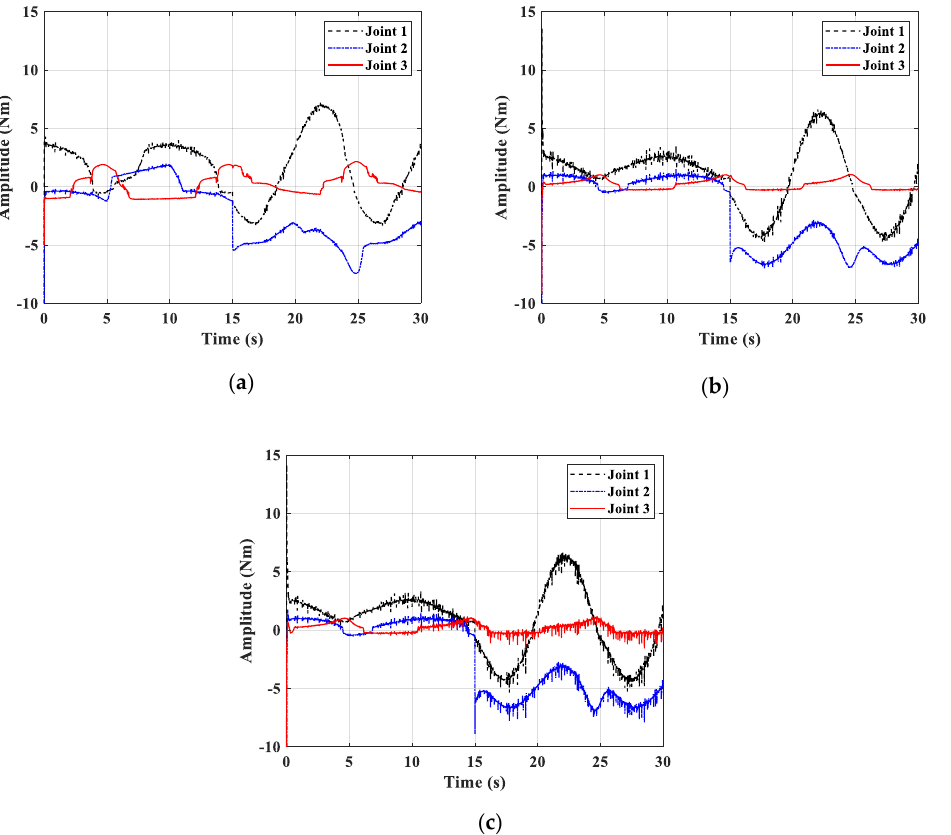
Figure 9. Control signals of the proposed control at 0.1 Hz: ( a ) backstepping control; ( b ) LESOBC; and ( c ) proposed control. Table 3. The root mean square error (RMSE) for the tracking errors of the manipulator at 0.1 Hz. Controllers